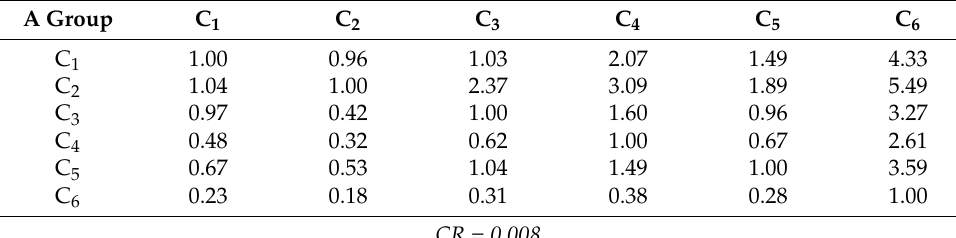
Table 5. Aggregated pairwise comparison matrix for group A.